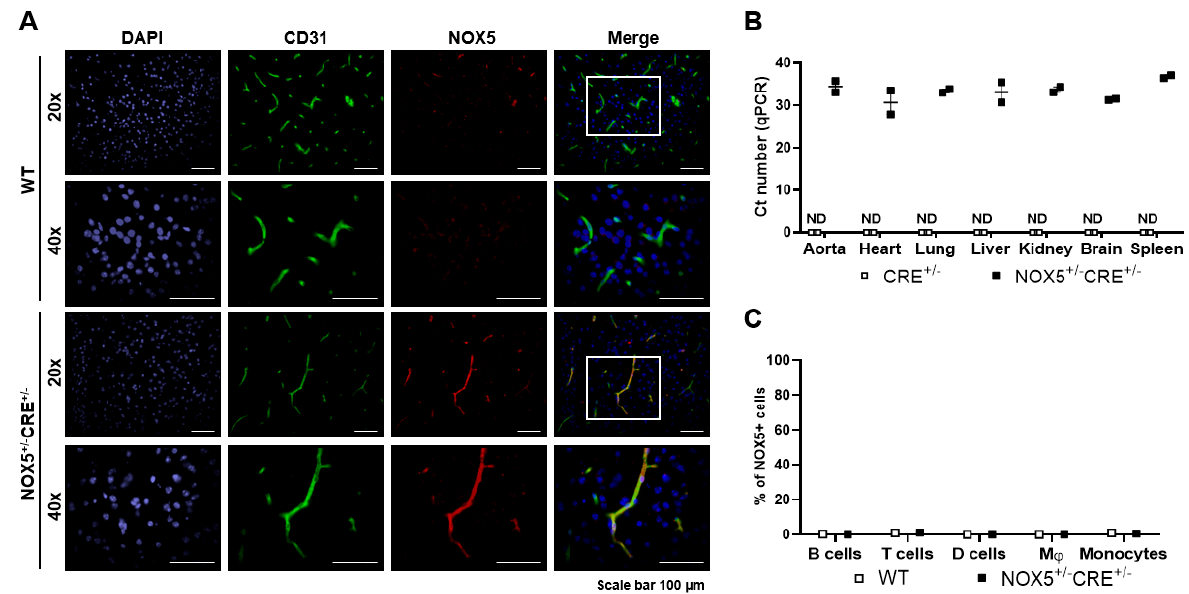
Figure 1. NOX5 expression in organs and circulating cells. ( A ) Representative IF images obtained from the brains of NOX5-expressing mice ( n = 2; NOX5 +/ − CRE +/ − ) and the negative control ( n = 1; WT). ( B ) NOX5 mRNA levels in different organs of NOX5-expressing mice (NOX5 +/ − CRE +/ − ) and the negative controls (CRE +/ − ). n = 2. ND: nondetected. ( C ) Representative percentage of NOX5 detection by flow cytometry in different subpopulations of circulating cells in the peripheral blood samples. NOX5-expressing mice ( n = 2; NOX5 +/ − CRE +/ − ) and the negative control ( n = 1; WT). D cells: dendritic cells and M φ : macrophages. The results are expressed as individual values ± SEM.